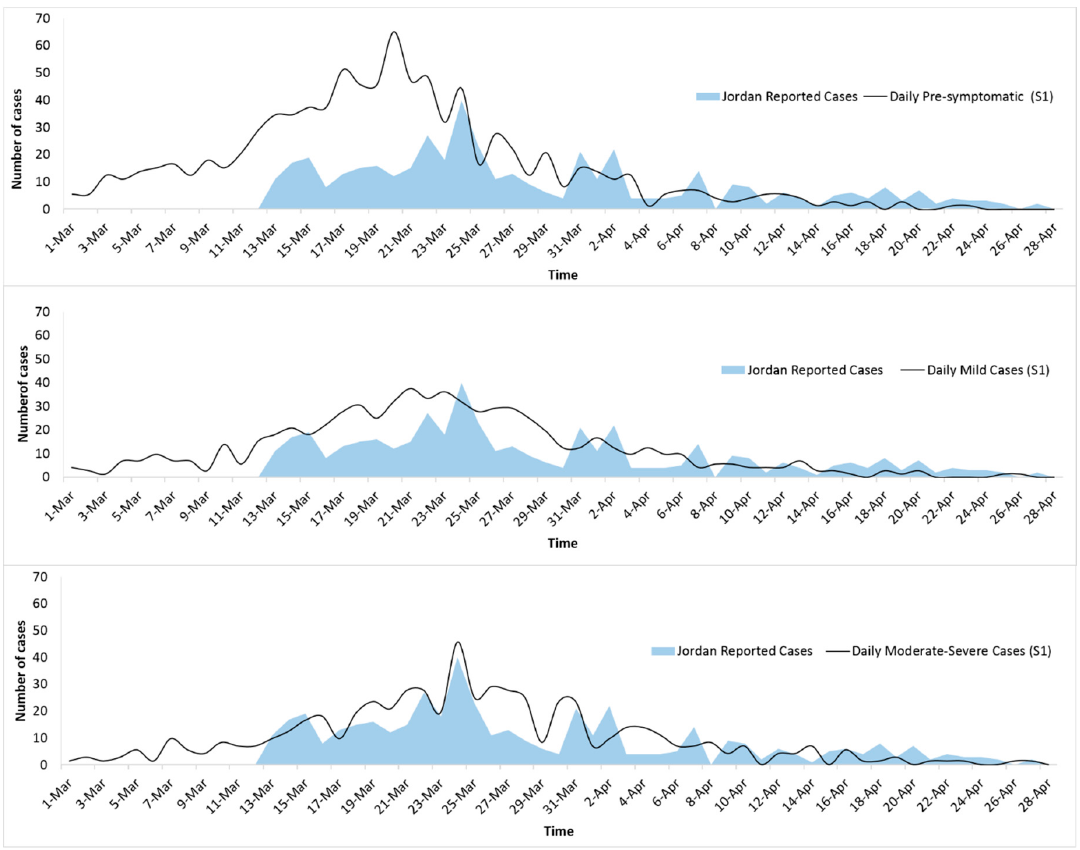
Figure 4. Number of daily new reported COVID-19 cases compared to S1-simulated numbers in the three compartmental states.